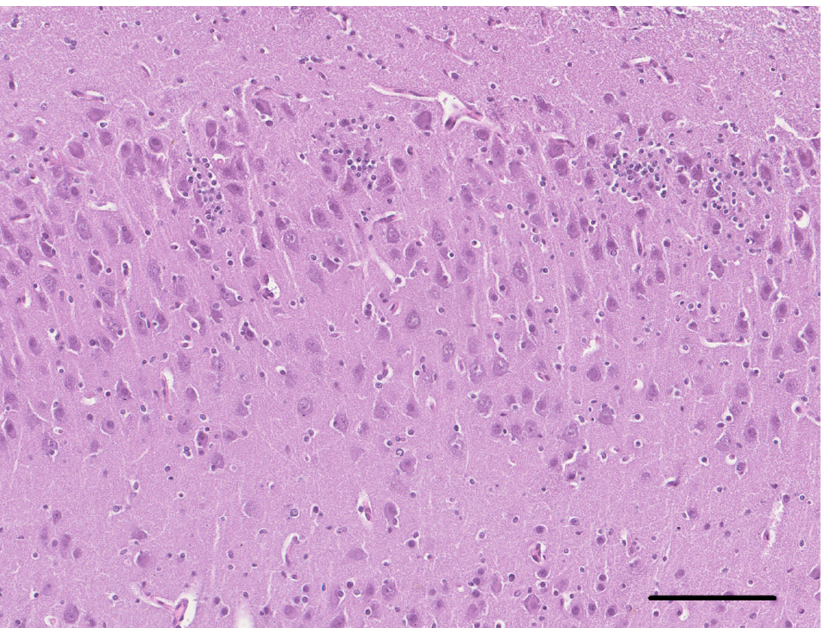
Figure 6. Hippocampus of dog 2. The pyramidal cell layer is disorganized and several nests of neuroblasts are intermingled (HE, bar = 125 µ m).